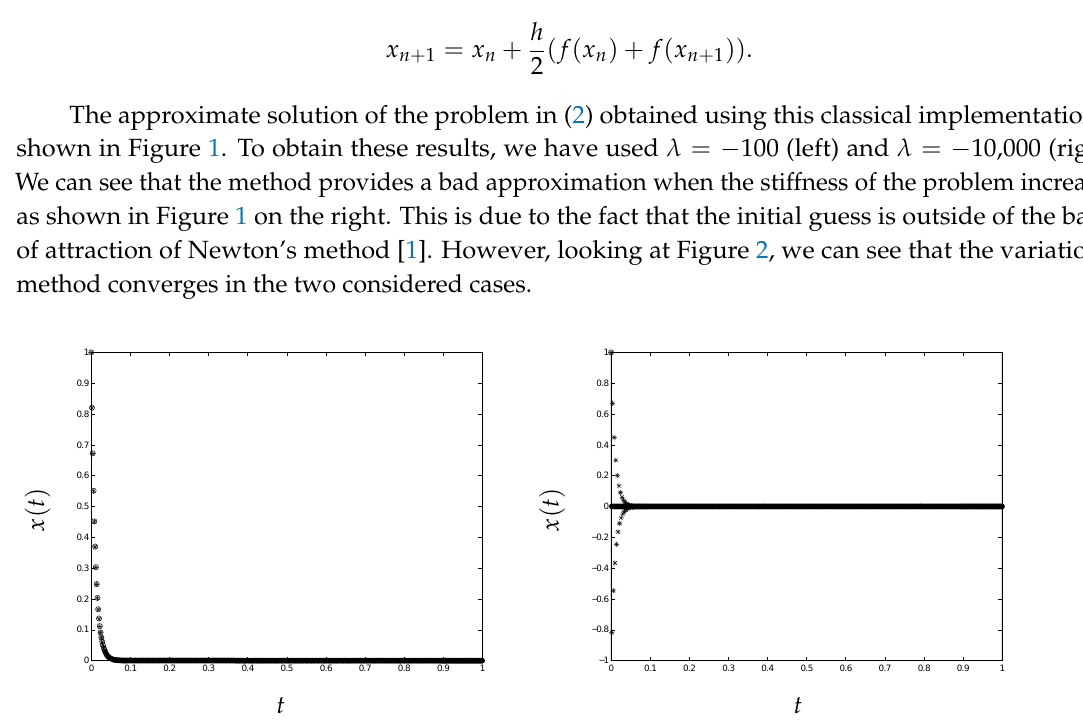
Figure 1. Classical implementation of the trapezoid rule. Nonlinear test problem (“o”, original; “*”, approximation). ( left ) λ = − 100 and ( right ) λ = −